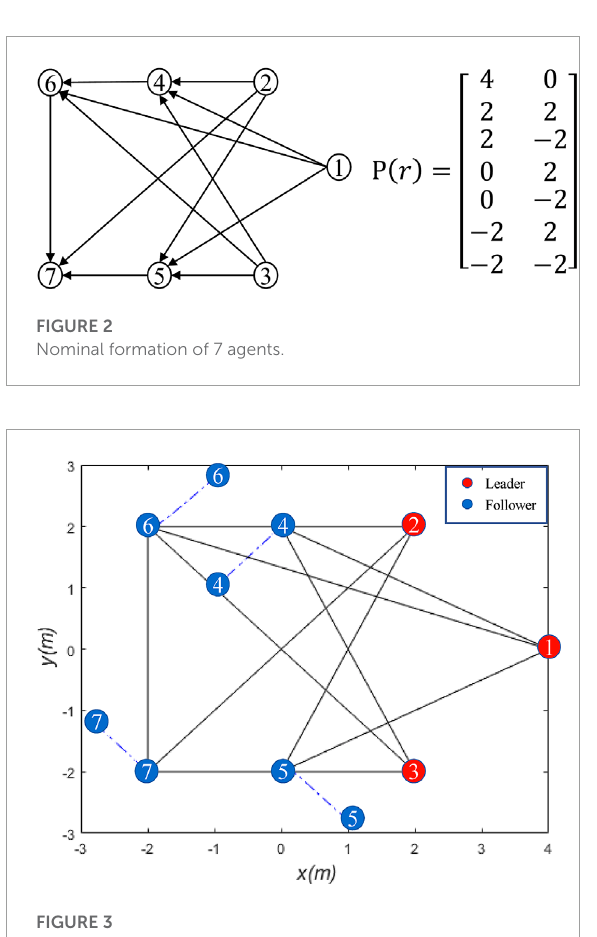
FIGURE 3 Trajectory of the agents when the leader speed is